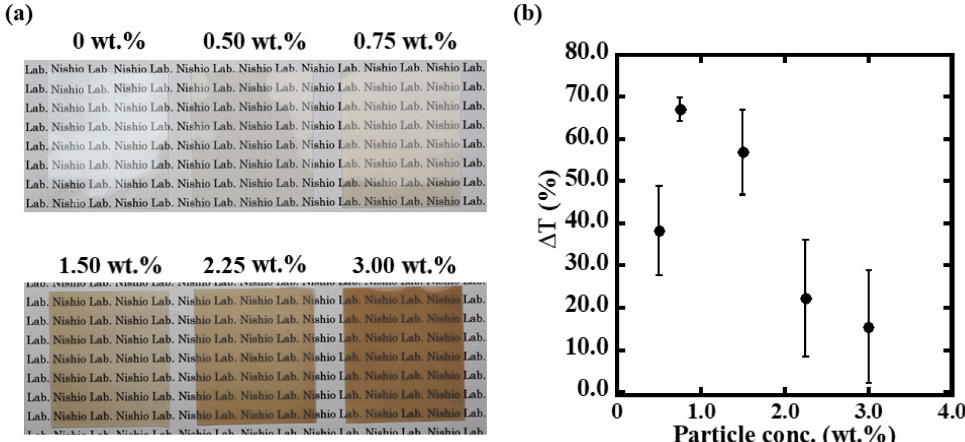
Figure 4. Dependence of transparency and H 2 response on the percentage content of Pt/WO 3 nanoparticles. ( a ) Typical images of sample membranes. ( b ) Transmittance change when the films were exposed to 100% H 2 gas measured at 800